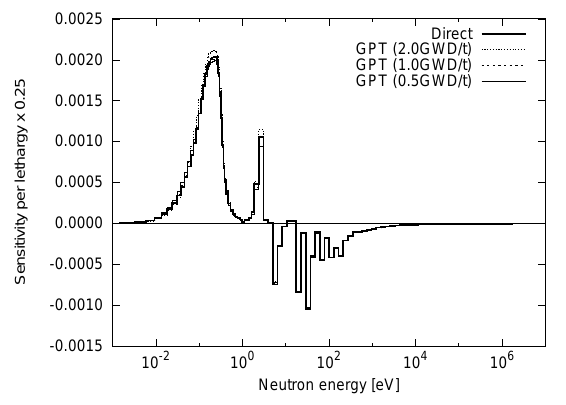
Figure 6. Sensitivities of Pu-239 number density to Gd-155 (n, γ ) cross section (infinite dilution condition)